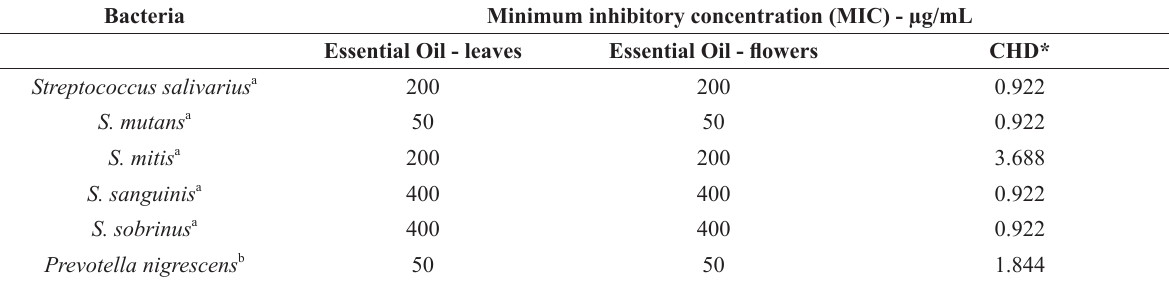
Antimicrobial activity of essential oils from E. klotzschiana against oral bacteria under study.